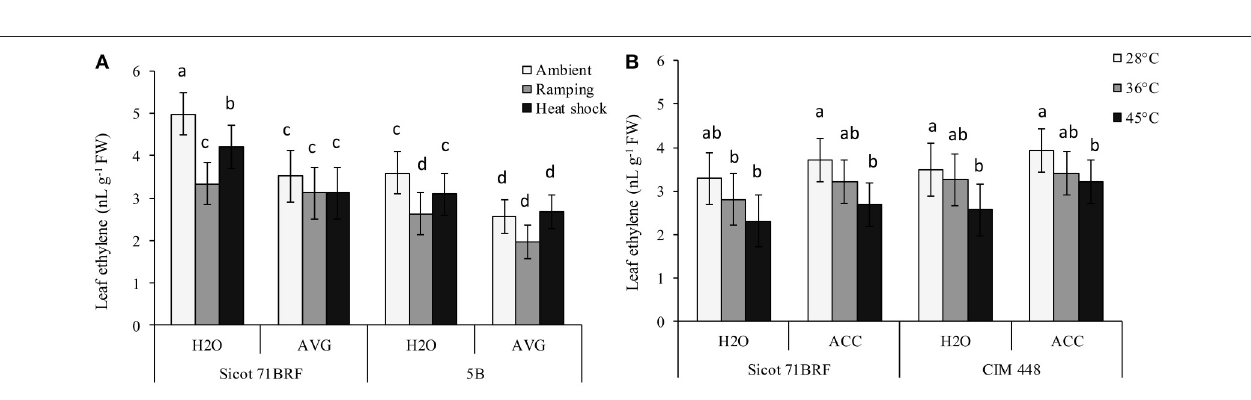
FIGURE 5 | (A) Effect of aminoethoxyvinylglycine (AVG) on ethylene release from leaf tissues of cotton genotypes Sicot 71BRF and 5B exposed to heat shock (45 ◦ C) and ramping heat (gradual rise in temperature to 45 ◦ C) for 7 days, data were collected at the termination of heat treatment. (B) Effect of 1-aminocyclopropane- 1-carboxylic acid (ACC) on ethylene release from leaf tissues of cotton genotypes Sicot 71BRF and CIM 448 exposed to heat shock (45 and 36 ◦ C) for 7 days, data were collected at the termination of heat treatment. Values are the mean of four independent replications, with the error bars representing SE and sample size = 4. Means sharing same letters within each figure are not significantly different at α =